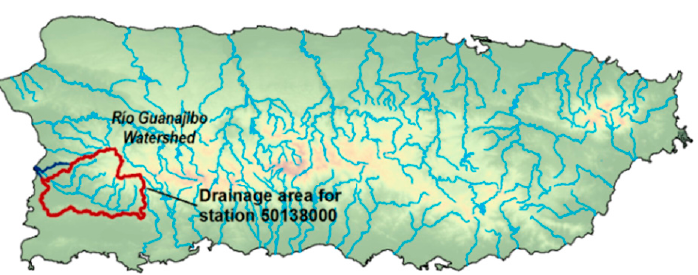
Figure 7. Guanajibo Watershed in western Puerto Rico. Images obtained from the USGS website. (https://waterdata.usgs.gov/pr/nwis/uv/?site_no=50138000&PARAmeter_cd=00065,00060, accessed on 1 April 2021).